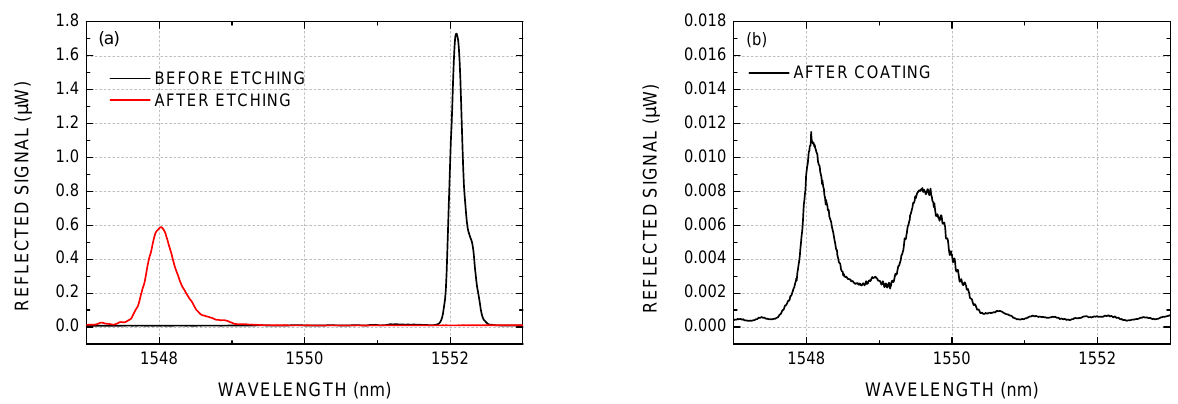
Figure 3. FBG reflected spectra: ( a ) before and after the etching process, and ( b ) after the PCDTBT:PDI film deposition.